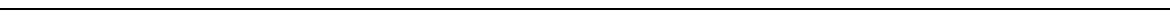
Fig. 1 Flies learn to devalue sugar value through taste recognition and a post-ingestion mechanism. a Pre-feeding fl ies for 1 min with non-nutritious L - glucose 24 h before olfactory conditioning with the same sugar induces signi fi cantly lower STM scores as compared to non-pre-fed fl ies or fl ies pre-fed with classical medium ( F (2,52) = 12.63; p < 0.0001; n ≥ 18; p > 0.999 in post hoc analysis between non-pre-fed fl ies and fl ies pre-fed with medium). In contrast, pre-feeding fl ies with nutritious D -glucose does not affect olfactory memory scores as compared to non-pre-fed fl ies or fl ies pre-fed with medium ( F (2,52) = 0.553; p = 0.578; n ≥ 18). However, pre-feeding fl ies with a mixture of D -glucose and phlorizin induces signi fi cantly lower olfactory memory scores as compared to D -glucose pre-fed fl ies ( t -test, t 37 = 2.544; p = 0.015; n ≥ 19). b PER (Proboscis Extension Response) scores with increasing concentrations of L -glucose in fl ies pre-fed with L -glucose or a mixture of D -glucose + phlorizin 24 h are similar to fl ies pre-fed with D -glucose or medium, as well as non-pre-fed fl ies ( F (16,1032) = 0.906; p = 0.494; n ≥ 47). c Flies pre-fed and conditioned with arabinose display signi fi cantly lower memory scores as compared to non-pre-fed fl ies conditioned with arabinose ( t -test, t 42 = 2.056; p = 0.046; n ≥ 21). d Pre-feeding fl ies with L -glucose and conditioning them with arabinose induces signi fi cantly higher memory scores in comparison to fl ies pre-fed and conditioned with L -glucose ( t -test, t 18 = 2.188; p = 0.042; n = 10). See also Supplementary Fig. 1. Means are ± SEM; statistical tests: t -test, one-way ANOVA, two-way ANOVA, and RM-ANOVA; NS: p ≥ 0.05; * p < 0.05 in comparison between two groups for t -test and in post hoc comparisons with other groups for